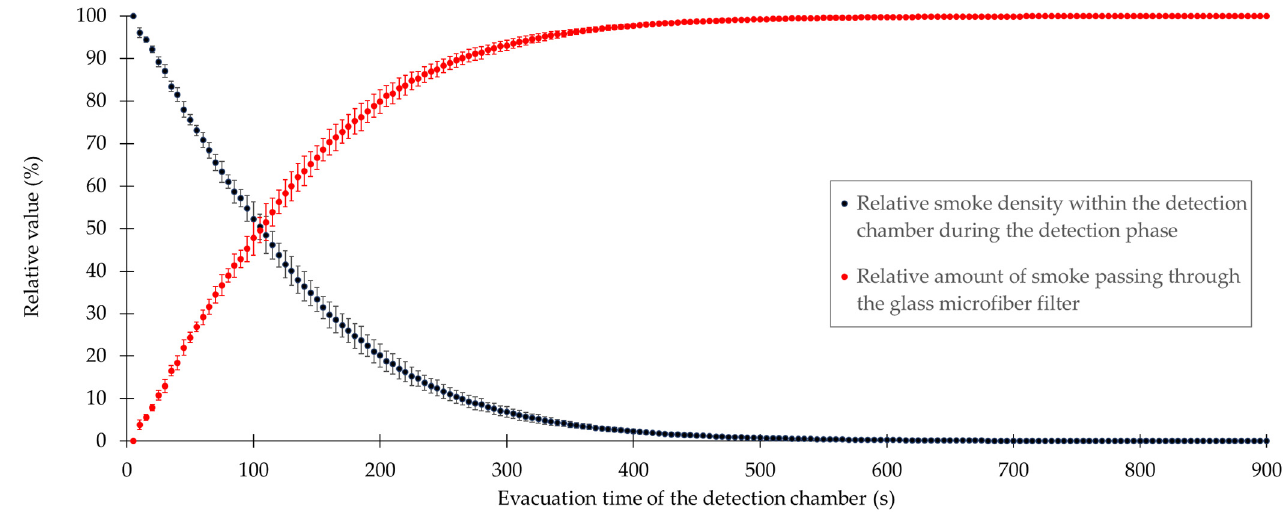
Figure 11. Relative values of the smoke density and the amount of removed smoke versus the evac- uation time of the detection chamber. evacuation time of the detection chamber.